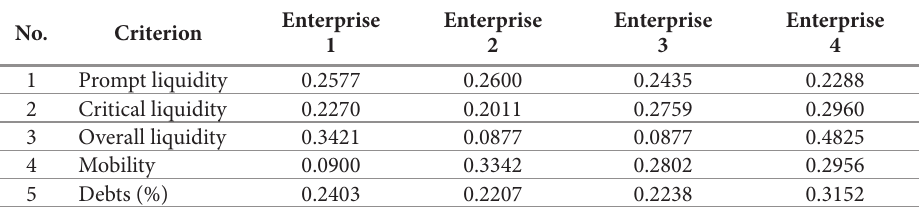
Table 2. Normalized values of the criteria